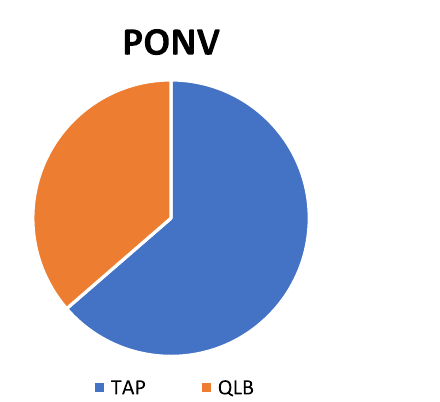
Fig. 4 Difference between TAP group and QLB group regarding complications. Data expressed as proportion, PONV, postoperative nausea and vomiting; TAP, transversus abdominis plane block; QLB , quadratus lumborum plane block, p ‑value > 0.05 is